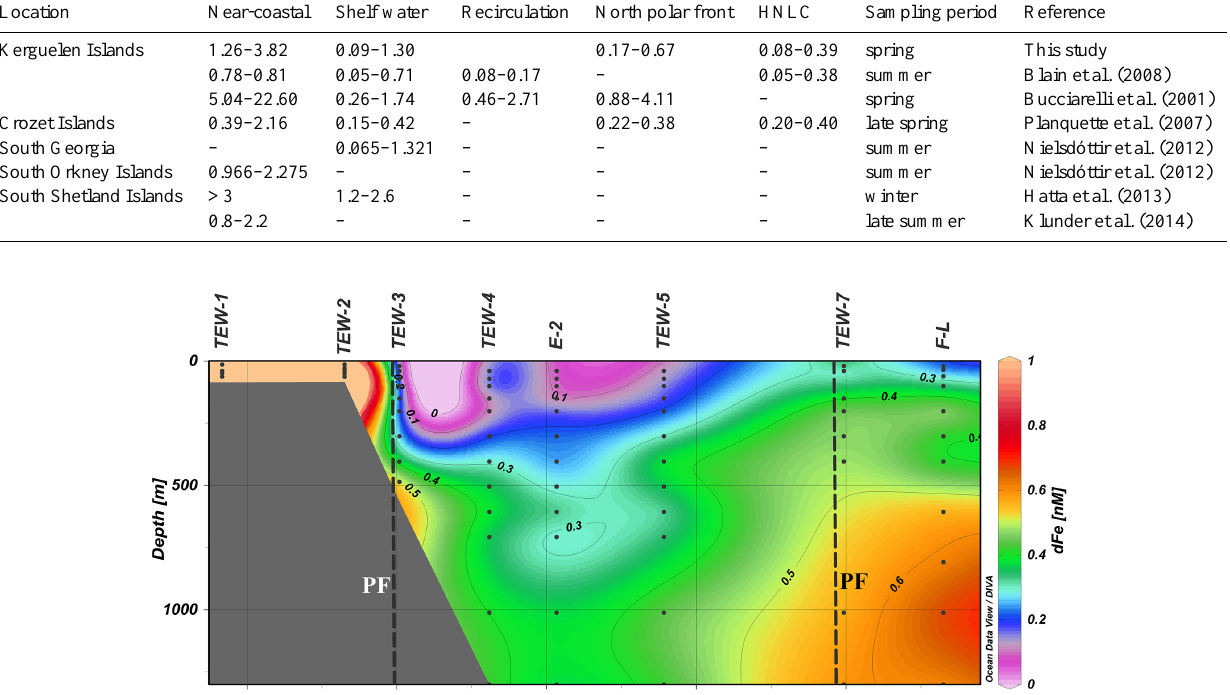
Figure 5. Concentrations of dFe (nmolL − 1 ) over the east–west transect. The PF position is indicated with black dashed lines. Stations TEW-1, TEW-2, TEW-3, TEW-4, E-2, TEW-5, TEW-7, and F-L were included in this section as they were sampled consecutively in a short time period (7 days) (Table